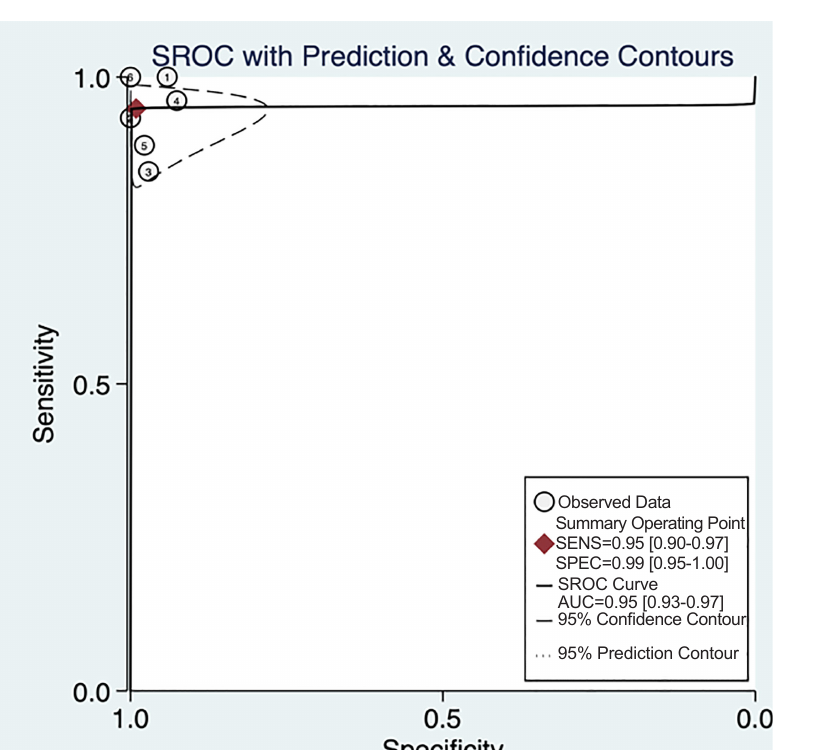
Figure 3. Summary receiver operating characteristic (SROC) curve with all studies. 1=Lam, 2=Muniz, 3=Riera, 4=Trigylidas, 5=Zerzan, 6=Lin. SENS, sensitivity; SPEC, specificity; AUC, area under the curve.